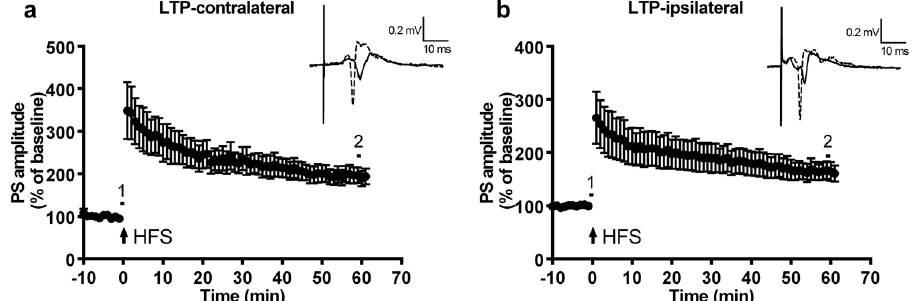
Figure 2. High-frequency stimulation of the unilateral side of the Dl evoked long-term potentiation (LTP) in the ipsilateral and contralateral side of the Dm. ( a ) LTP of the contralateral side of the Dm (group data). ( b ) LTP of the ipsilateral side of the Dm (group data). High-frequency stimulation (100 Hz) was applied (arrow) in the Dl division. The amplitude of the PS of both sides after LTP induction was 1.5 times larger than the amplitude at baseline, and this increase could last at least 1 hour. Using paired t-test to compare the amplitude at 60 min (point 2) with the amplitude at baseline (point 1): (193.89 ± 17.31%, n = 8, p = 0.0010; ipsilateral: 164.83 ± 16.05%, n = 8, p = 0.0012). Each point represents the mean ± SEM of the PS amplitude. n = 8.